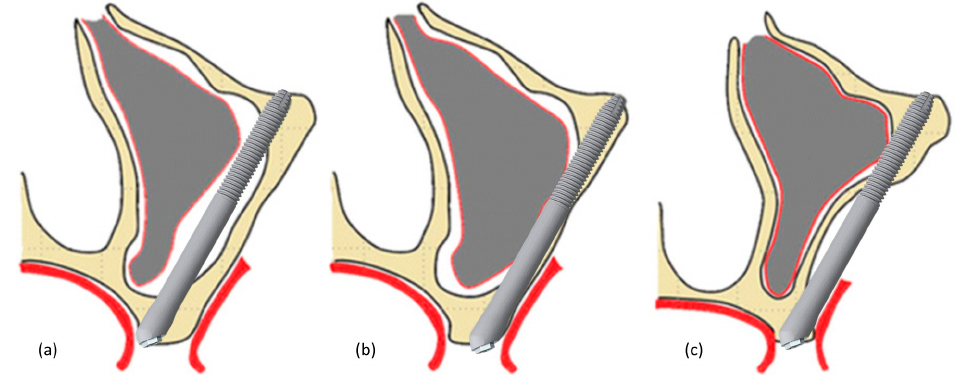
Figure 1. Illustration of the zygomatic implant placement techniques: intrasinus ( a ), in the wall of the maxilla ( b ), and extrasinus ( c ). maxilla ( b ), and extrasinus ( c